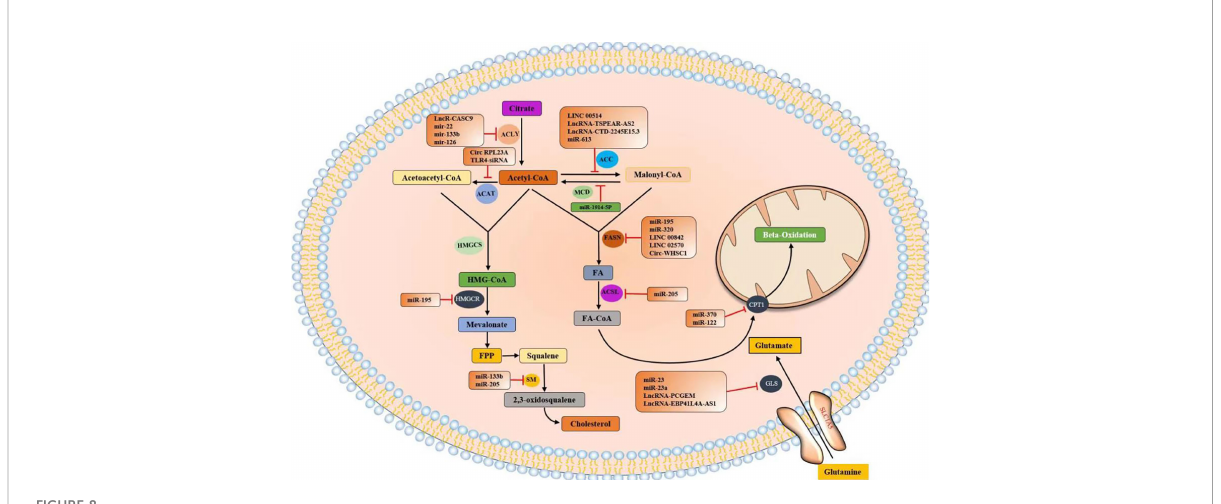
FIGURE 8 Noncoding RNAs regulate the expression of lipid metabolism